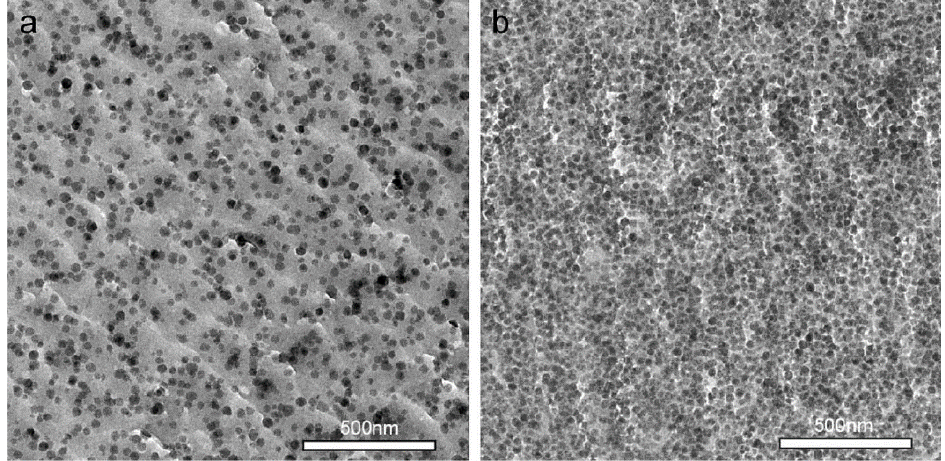
Figure 1: TEM micrograph of nano/polymer coating with (a) 10wt% and (b) 40wt% nanosilica particles